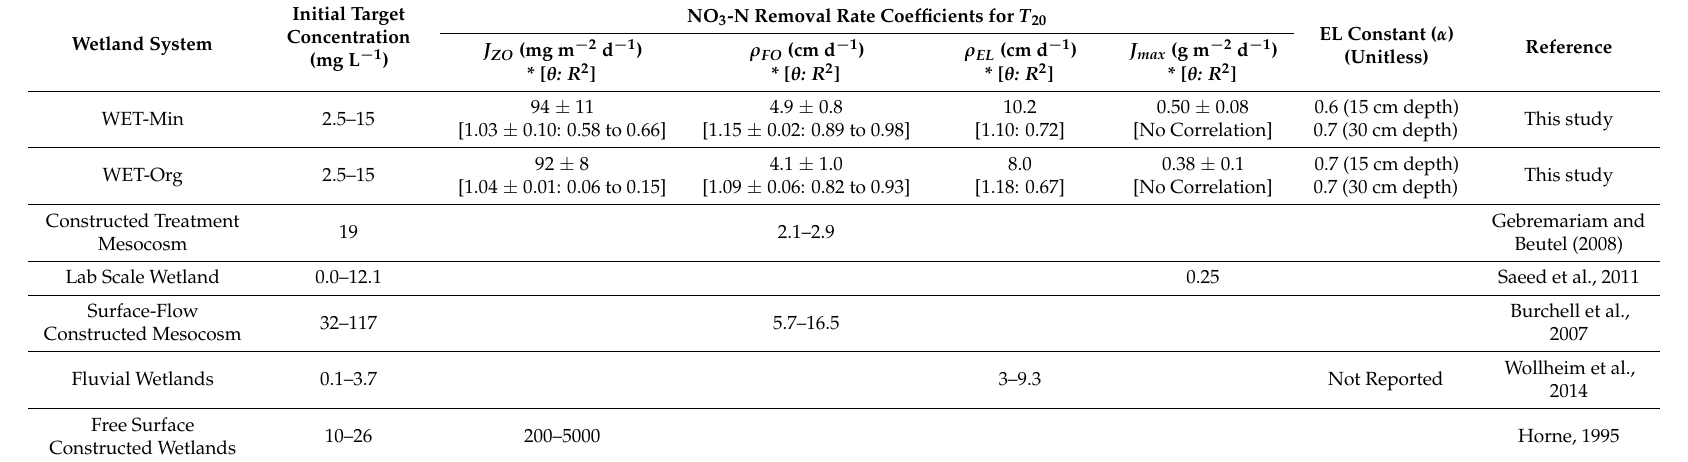
Table 4. List of areal NO 3 -N removal rate coefficients and efficiency loss constants ( α ) for average water temperature of 20 ◦ C